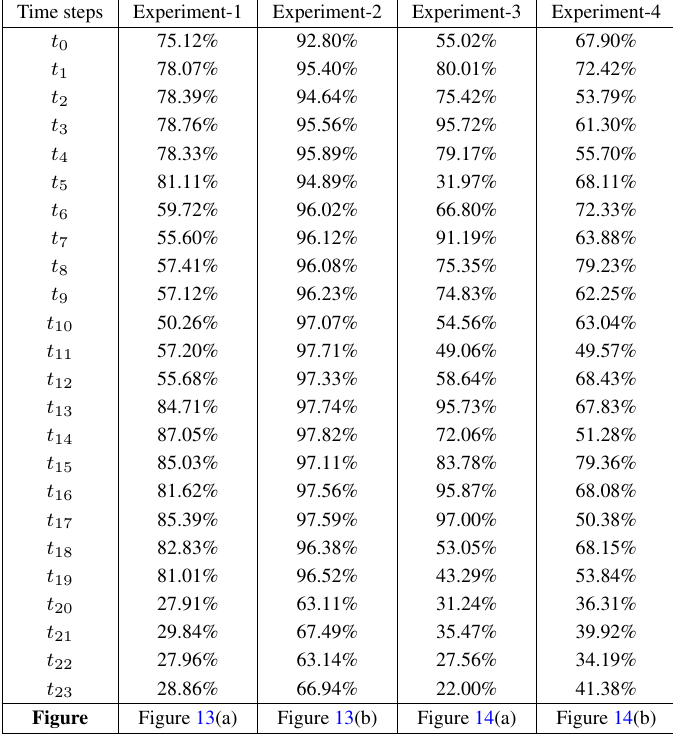
Table 2. Predicted Probabilities Revealing Actual Situations on Sensor One by the ESA. Time steps